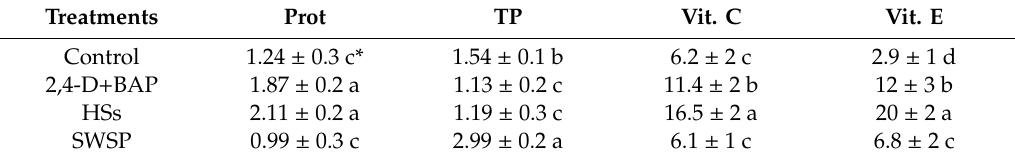
Table 4. Pinus laricio callus grown parameters after 28 days of growth on hormones free culture medium (control), with hormones (2,4D-BAP) or humic substances (HSs) or soil water soluble phenolic fraction (SWSP): total protein (Prot, mg g − 1 DW), phenols (TP, mg g − 1 DW), vitamin C (Vit. C, mg 100 g − 1 DW), and vitamin E (Vit. E, µ g g − 1